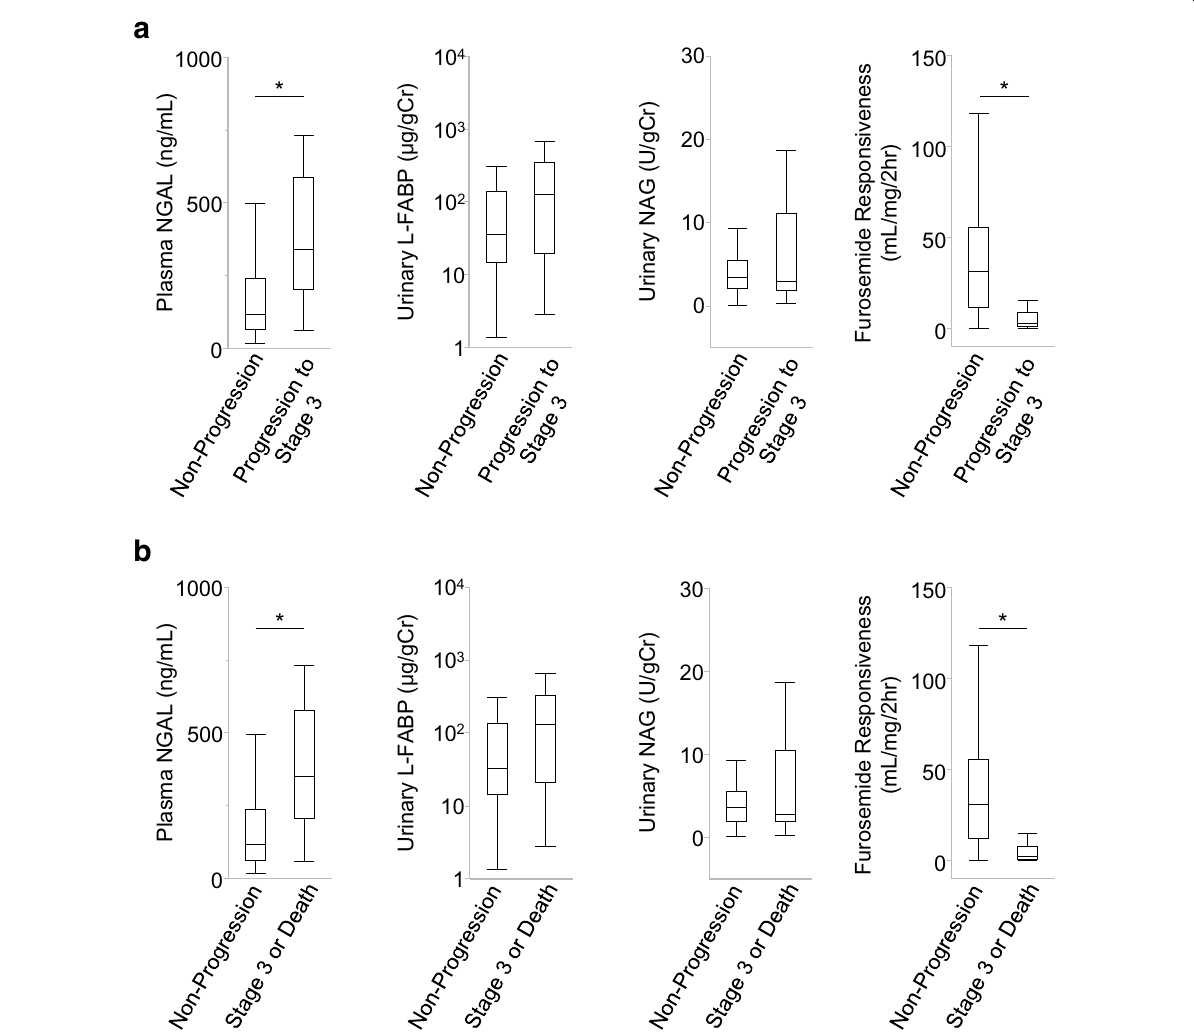
Fig. 2 Biomarkers and furosemide responsiveness (FR) in AKI progression. The boxplots show the differences in the AKI biomarkers and FR between patients a without and with the progression to AKI stage 3 and b without and with the progression to AKI stage 3 or death within 1 week. *p <